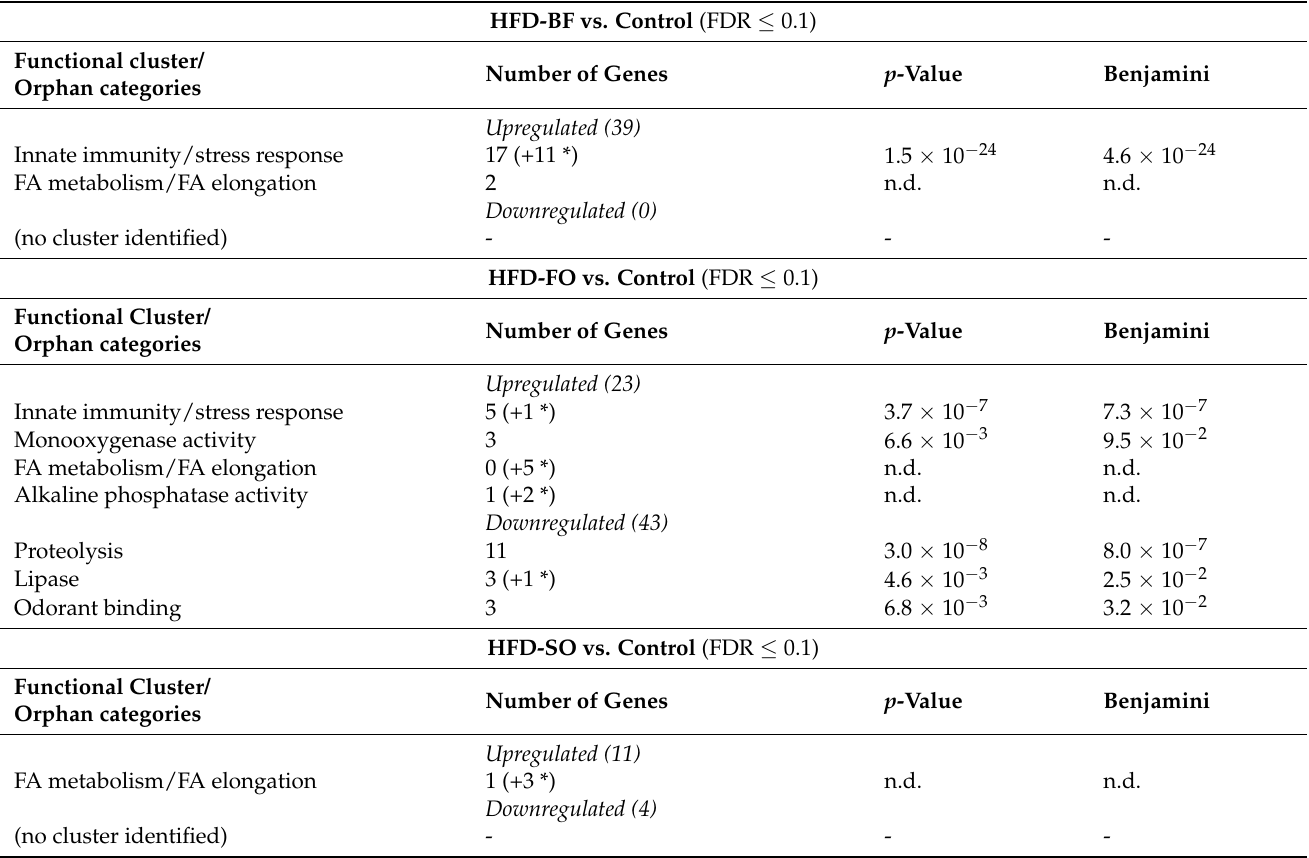
Table 3. Enrichment analysis of the transcriptional changes induced in D. melanogaster females by an HFD-BF, HFD-FO and HFD-SO, respectively. Female D. melanogaster w 1118 were fed ad libitum with SY control diet or experimental HFDs additionally supplemented with 12% ( w / v ) butterfat (HFD-BF), sunflower oil (HFD-SO) or fish oil (HFD-FO). Flies were maintained under standard conditions for 3 days before they were harvested for RNA isolation from whole-body lysates. RNAs were sequenced by a HiSeq3000/HiSeq 4000 system. The genes that were significantly up- or downregulated (threshold FDR ≤ 0.1 and fold change > 1.5/< − 1.5) by the respective HDF diet were separately analyzed for functional annotation clusters using the DAVID software tool. The functional clusters obtained were populated with matching genes from a literature search. Moreover, if at least two genes identified via eye inspection could be associated with an obviously relevant biological function; they were added as orphan categories recognizable by the lack of statistical